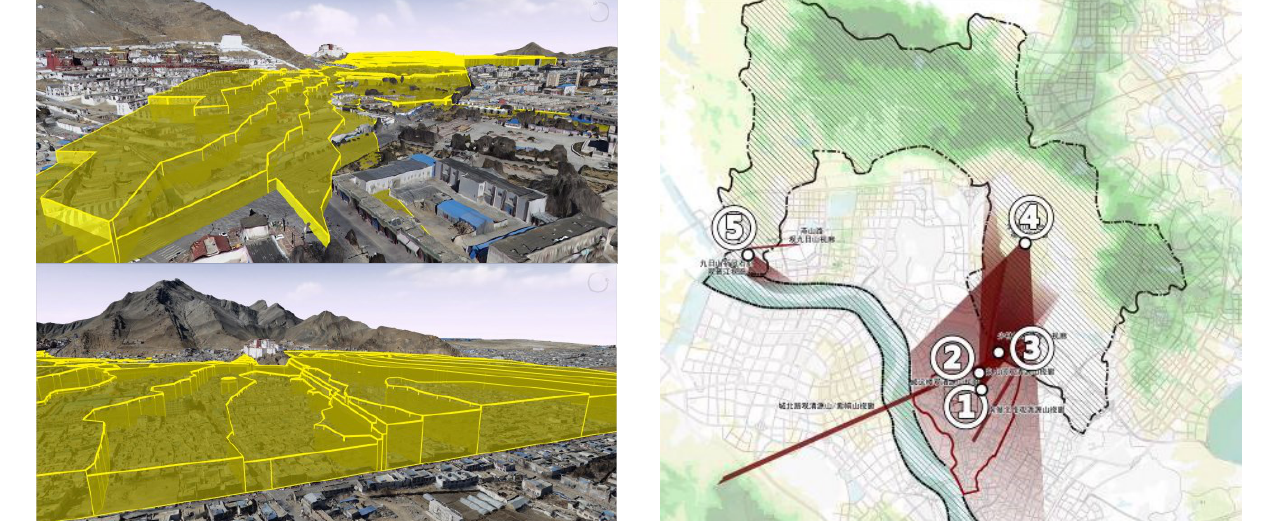
Drawing tangent lines from Quanshan ② From Quanshan Gate to 300-meter contour line of Gate viewing Qinyuan Mountain. The range of the Qinyuan visual corridor is set by the projection Mountain of the three 3D lines onto the plane. (about 1/3 of the mountain body is in sight)